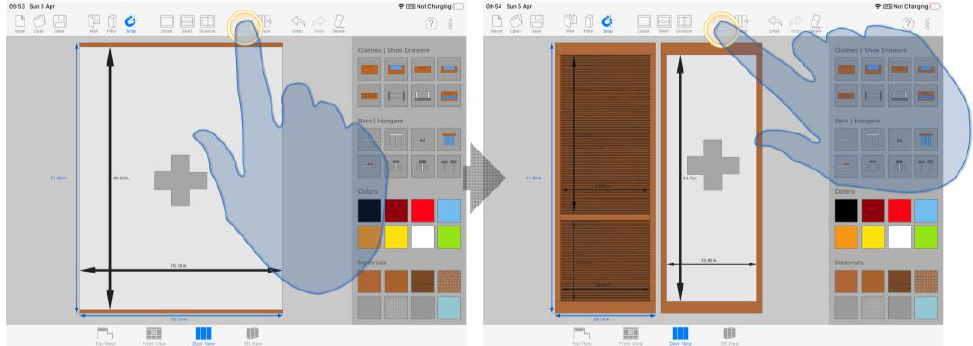
Figure 5. Door creation process. Each single tap on the corresponding button triggers the computations needed to parametrically define a new door and transform the position and scale of the previously created ones.